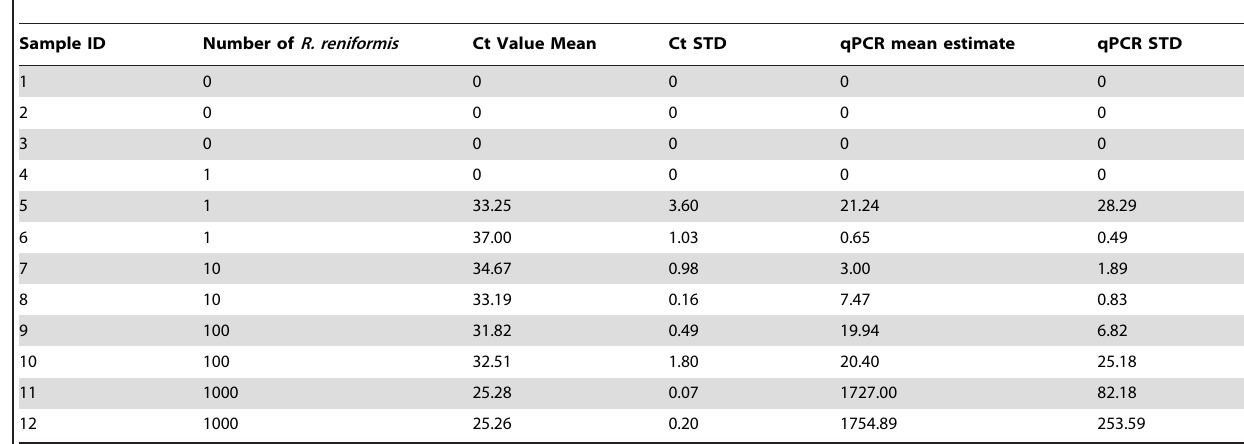
Table 4. The Rr- b -TUB qPCR assay estimates of nematodes from a serial dilution of the nematode suspension.